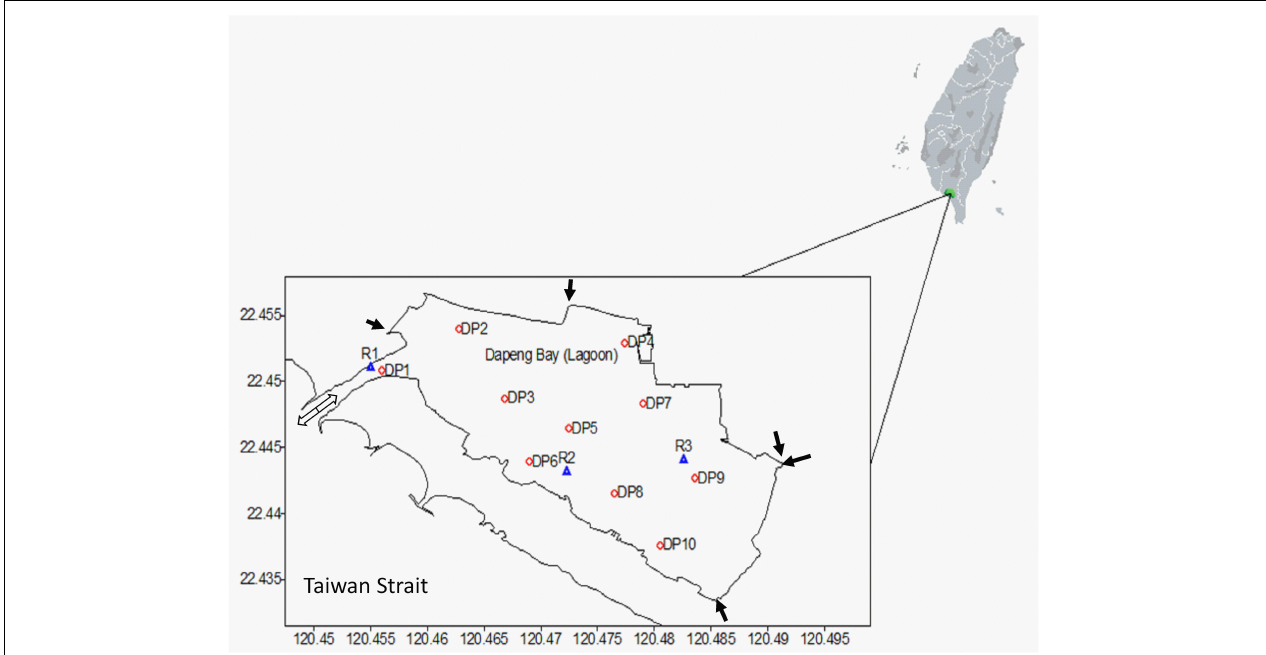
FIGURE 1 | Long-term real-time monitoring sites (R1–R3) and seasonal survey stations (DP1–DP10) of water trophic levels in Dapeng Bay, Southern Taiwan. The five arrows represent the small drainage channels. The hollow arrow represents the inlet-outlet to the sea.